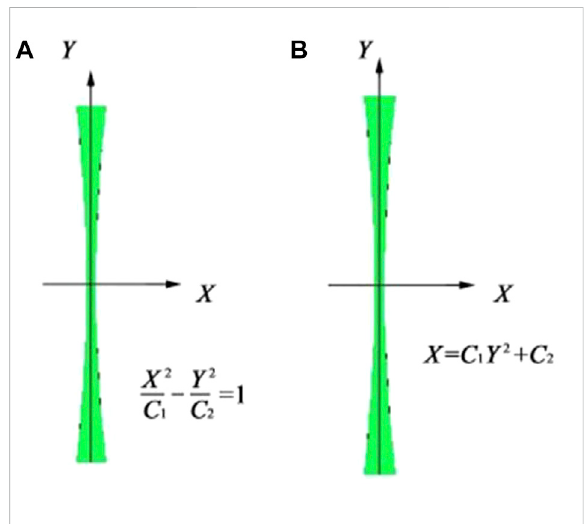
FIGURE 9 Failure styles of the diaphragm. (A) New hyperbolic pro fi le (B) Parabolic pro fi